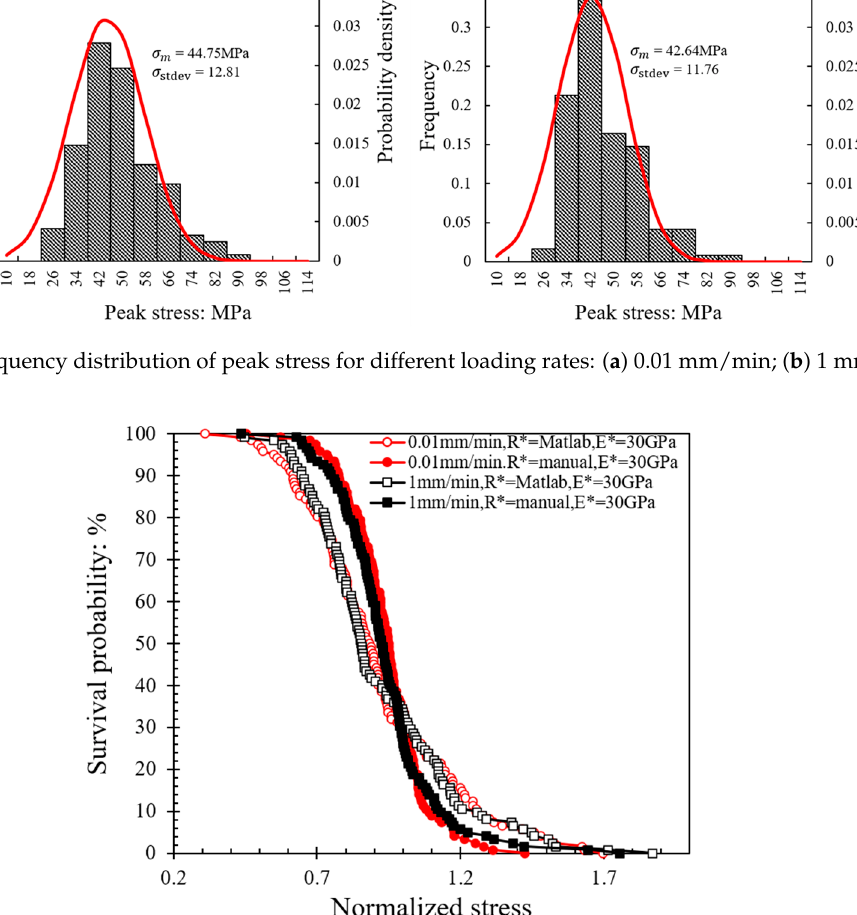
Figure 7. Survival probability against normalized stress curves at different loading rates applying